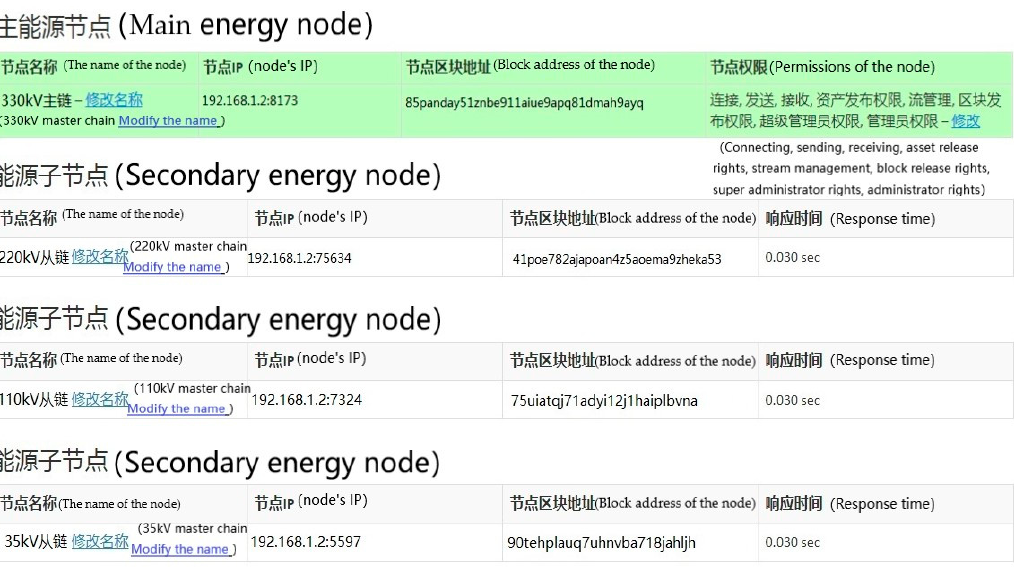
Figure A3. Setting the permissions of the slave node.